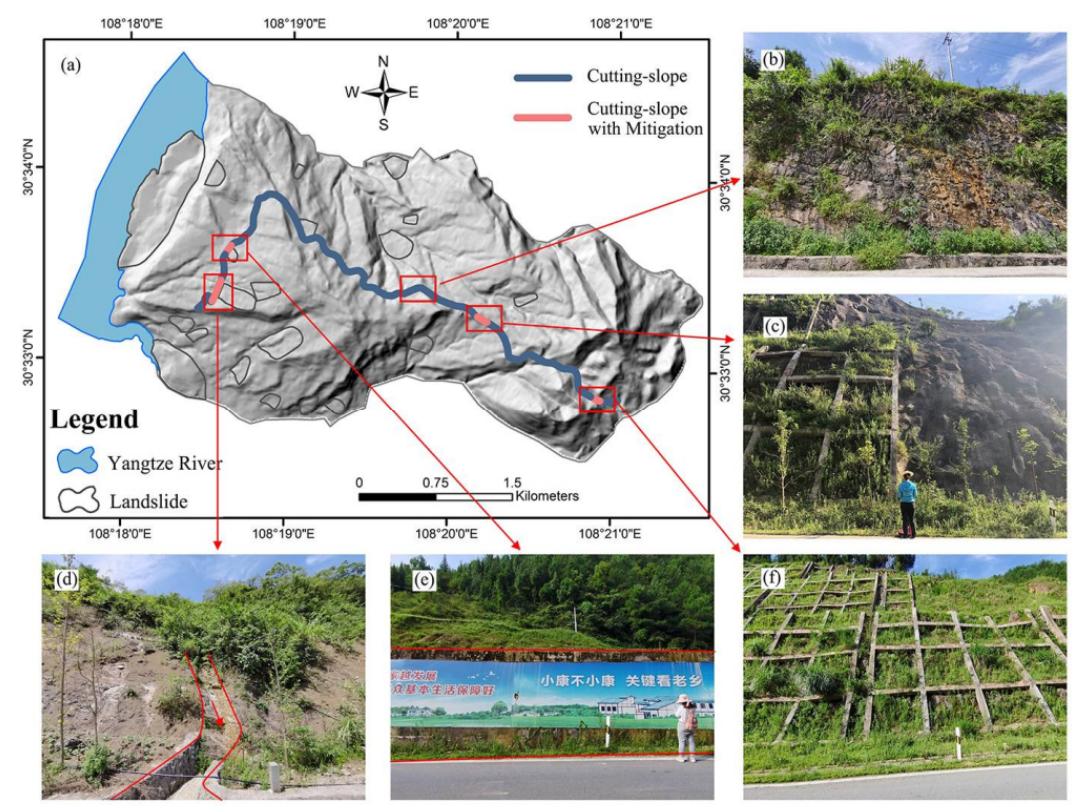
Figure 10. ( a ) The map of G69; ( b ) Cutting-slope without mitigation; ( c ) Cutting-slope with soil improvement techniques; ( d ) Cutting-slope with drainage techniques; ( e ) Cutting-slope with retaining wall; ( f ) Cutting-slope with retaining structure.